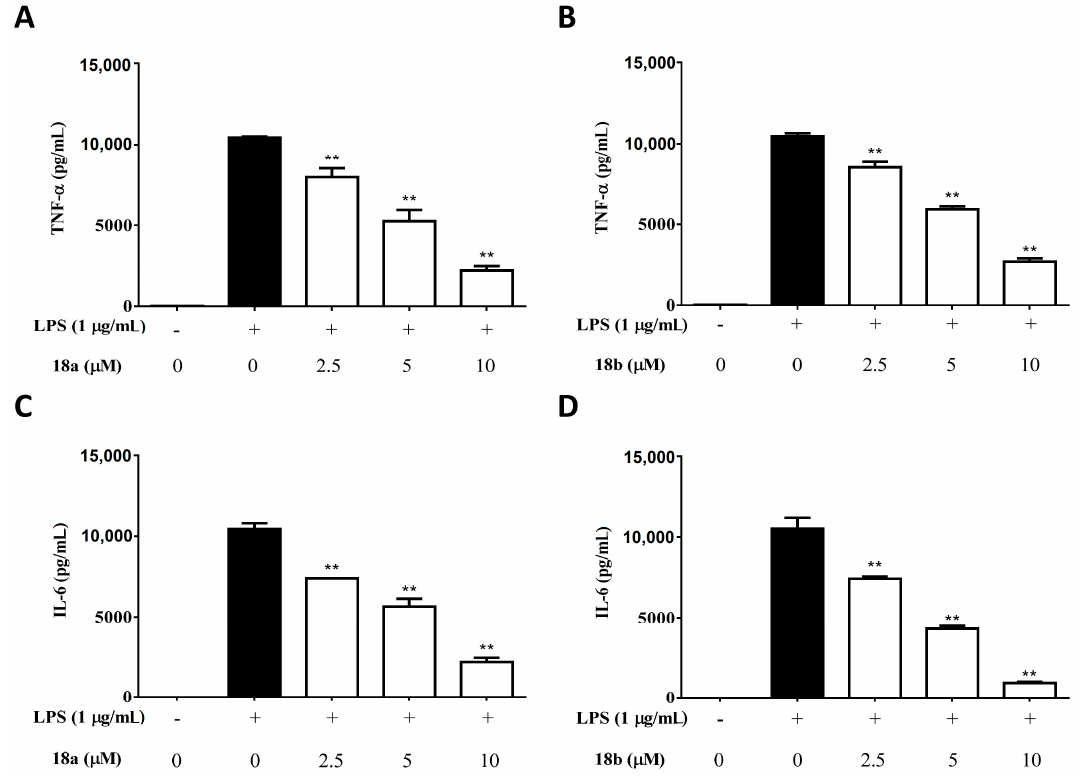
Figure 3. Effects of compouds 18a and 18b on the production of pro-inflammatory cytokines by LPS-activated J774A.1 cells. Cells were pre-treated with compounds 18a and 18b at different concentrations (0, 2.5, 5 and 10 µ M) for 1 h, and then incubated with LPS (1 µ g/mL) for 24 h. Cell culture supernatant was harvested and analyzed the concentration of ( A , B ) TNF- á and ( C , D ) IL-6 by ELISA. Data are presented as means ± SD of three independent experiments. “+”means treated with LPS; “ − ”means untreated. Statistical significance was represented as follows: * p < 0.05 and ** p < 0.01 vs LPS alone.